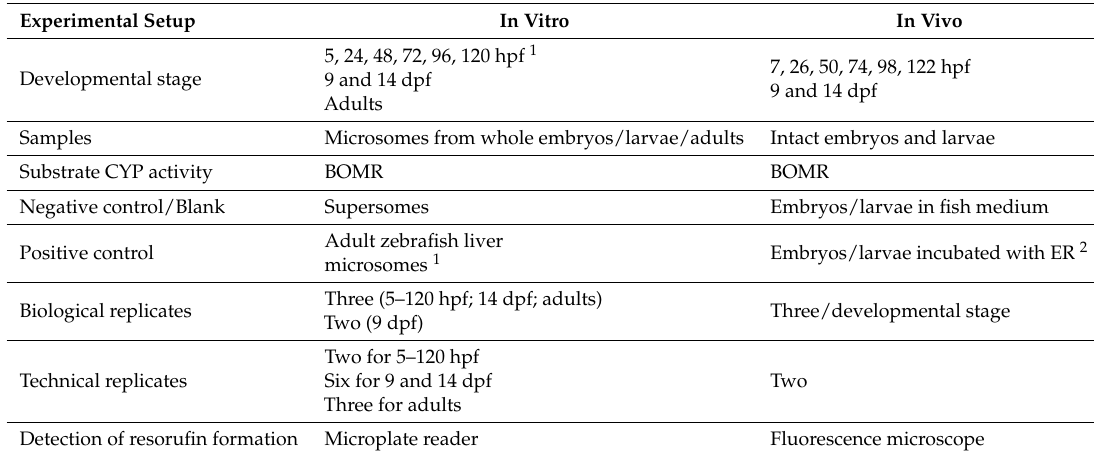
Table 1. Comparison of the experimental setup between in vitro and in vivo